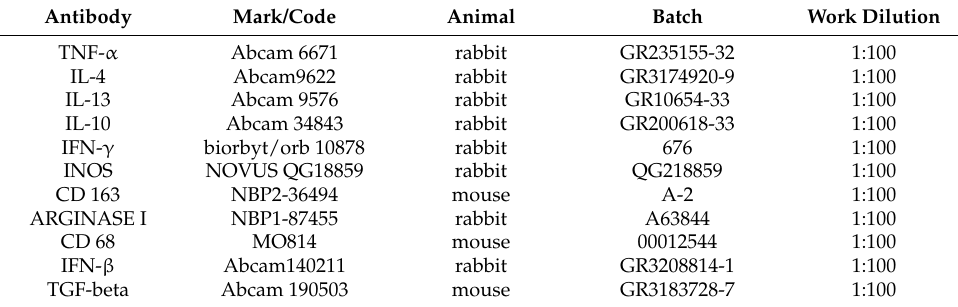
Table 3. Specific monoclonal antibodies used in the